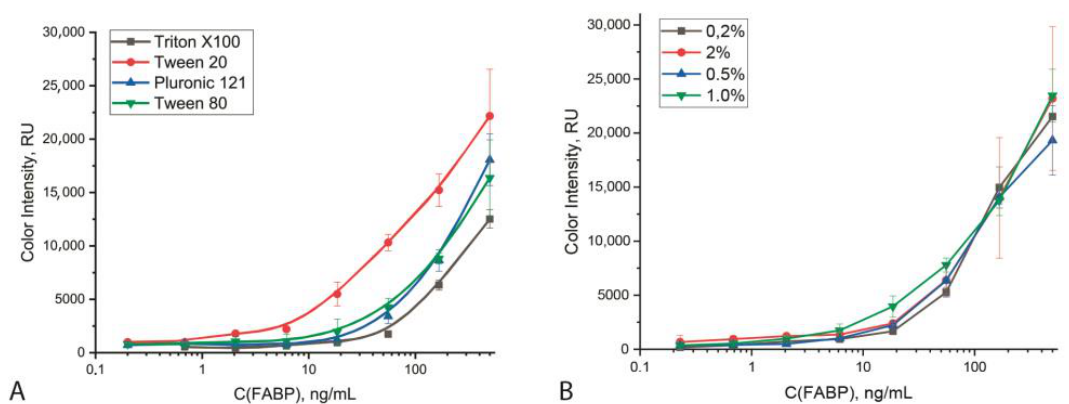
Figure 3. Dependence of the intensity of coloration of the analytical zone of the test strip on the nature of detergents (used at 1% concentration) ( A ) and the detergent concentration (for the case of Tween 20 use) ( B ) ( n = 5).